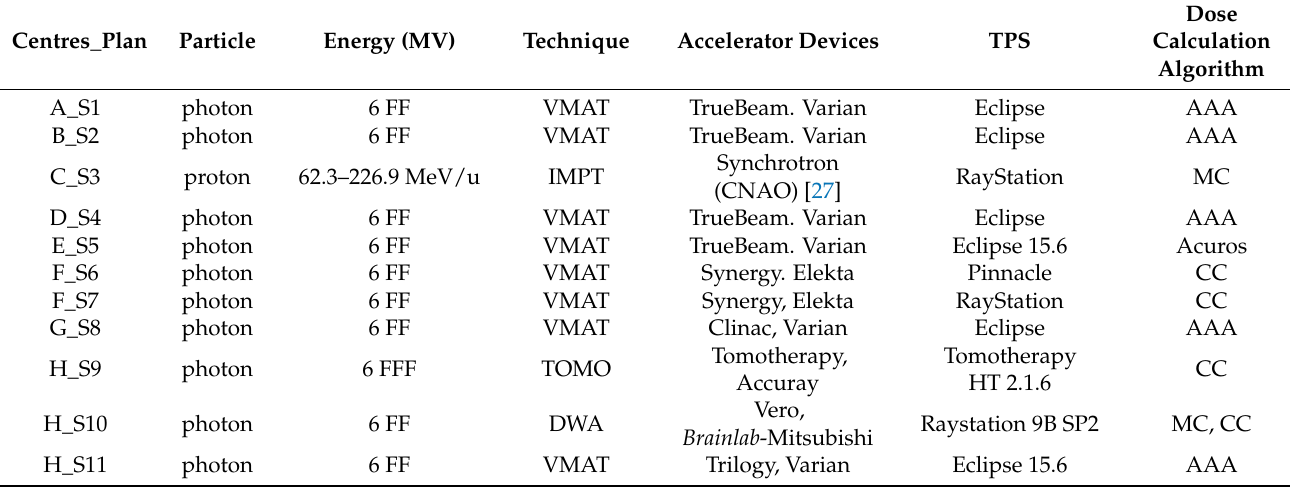
Table 3. List of the eleven plans generated by the centres involved in the study, type of particle, beam energy, delivery technique, kind of Linac, treatment planning system and dose calculation algorithm.